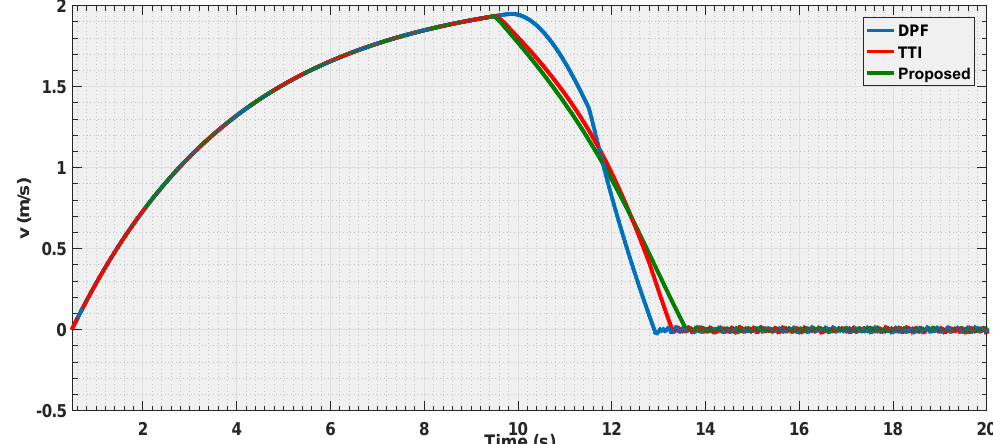
Figure 19. Velocity estimation by the three evaluated algorithms Experiment 3 .